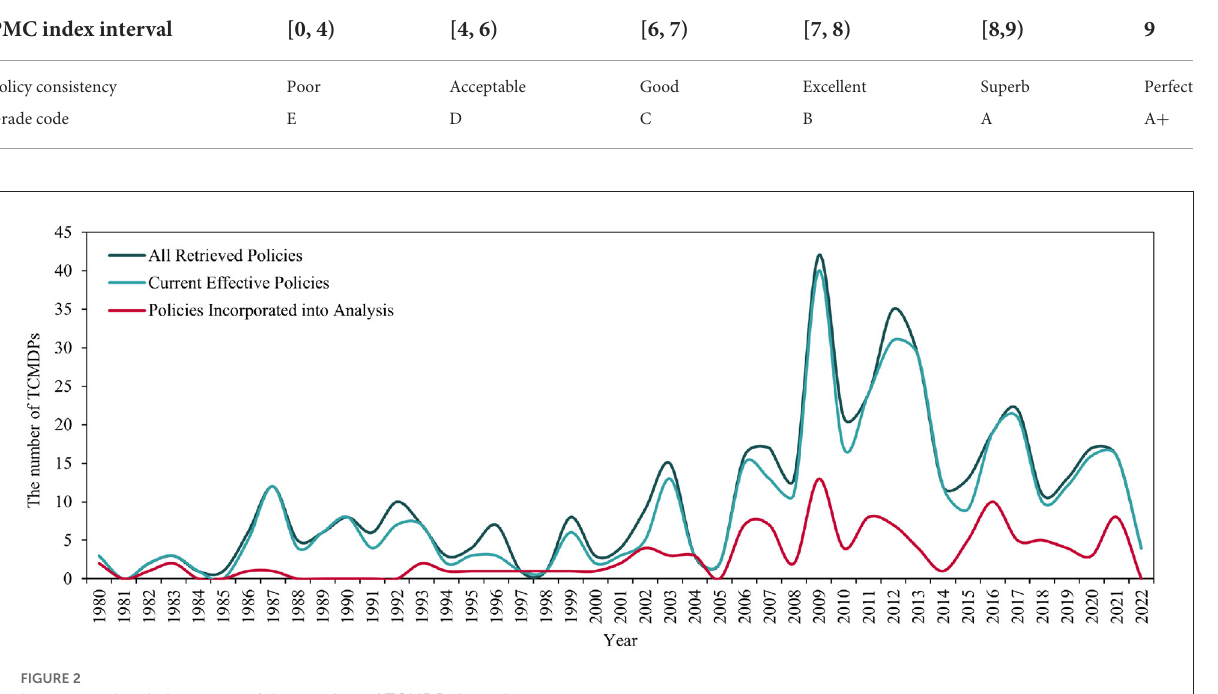
TABLE 3 Consistency categories for TCMDPs.